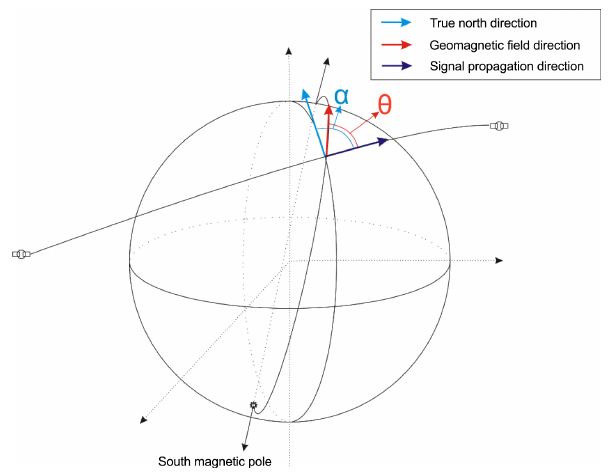
Figure 8. Sketch of the radio occultation azimuth.